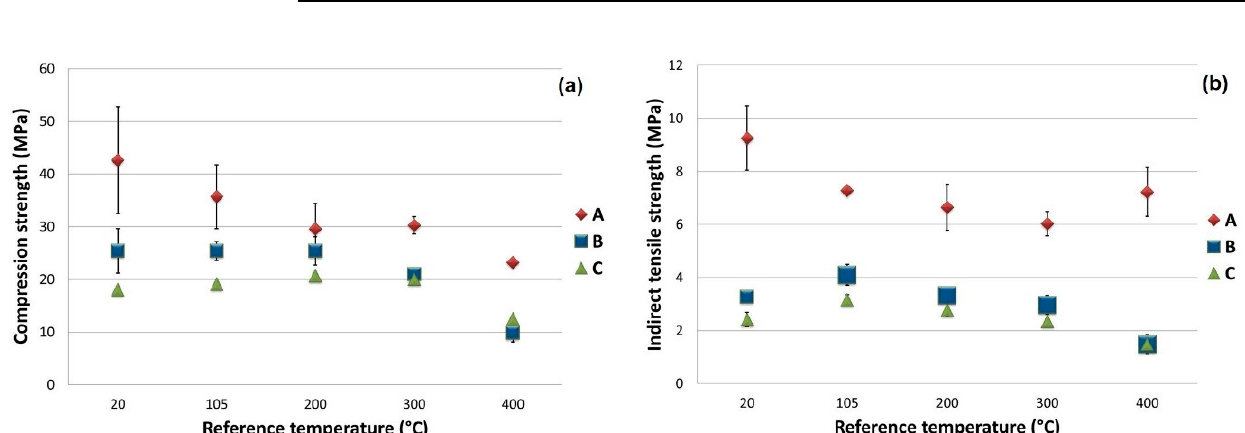
Figure 11. Average compressive ( a ) and indirect traction ( b ) strength, in MPa, for the various concrete mix designs, as a function of the heat treatment temperature .